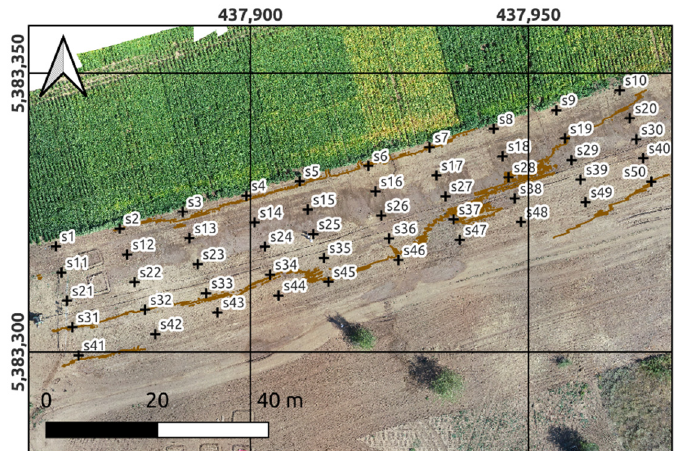
Figure 2. Orthophoto of the test plot with traces of surface runoff formed as a result of soybean irrigation. Brown lines represent relief isolines with contour intervals of 0.35 m.